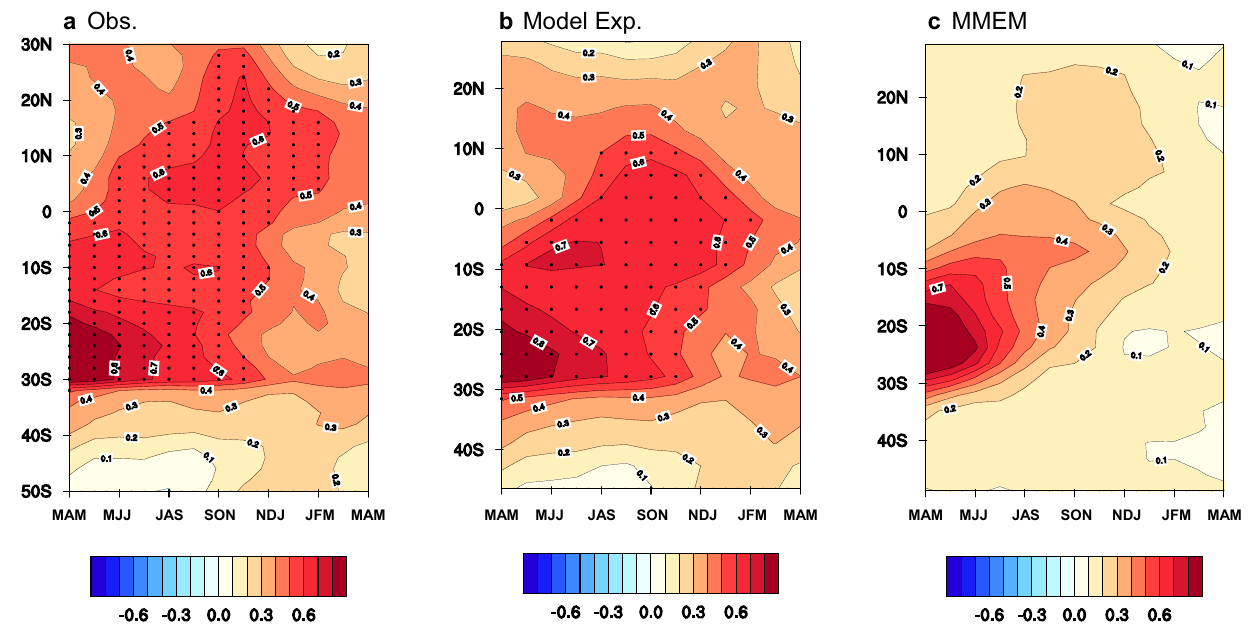
Fig. 3 Meridional evolution of SWP SST signal. The propagation of SWP SST signal indicated by the lagged correlations of the MAM SWP index with zonally averaged SST (115°E – 160°E) in the following consecutive-3 months. a is the observation, b and c are for pacemaker experiment and SOM multi-model ensemble mean, respectively. The dotted shading in a and b indicates the correlation is signi fi cant at the 95% con fi dence